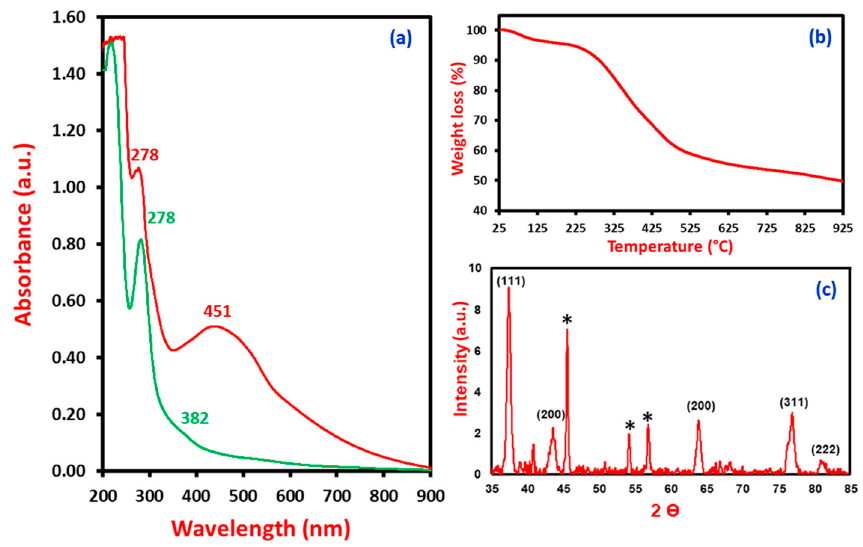
Figure 2. UV-Vis spectrum and XRD diffractogram of Ag NPs prepared from the extract of cranberries. ( a ) UV spectra of pure cranberry extract (green line) and as-prepared Ag NPs (red line), ( b ) TGA analysis of Ag NPs and ( c ) XRD diffractogram of Ag NPs. Note: the peaks marked with asterisks could be due to the inorganic contents of the cranberry extract.